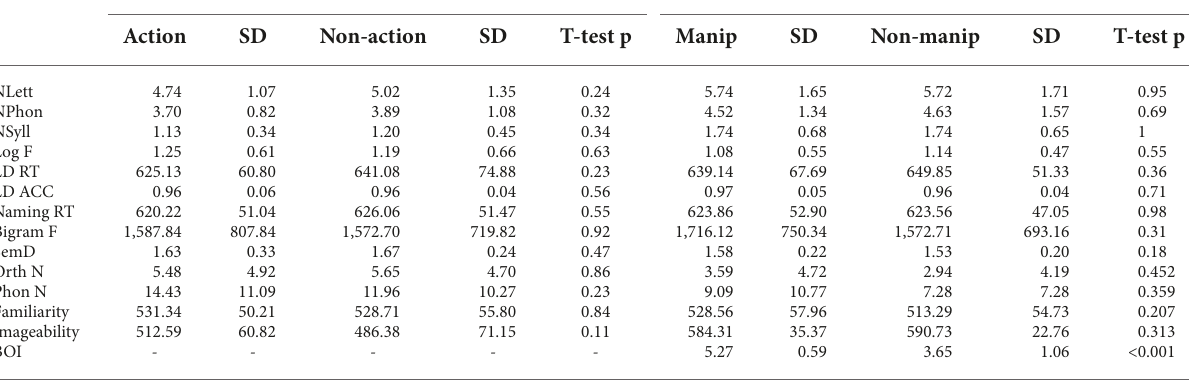
TABLE 1 Characteristics of words used in the lexical decision task. Verbs Nouns